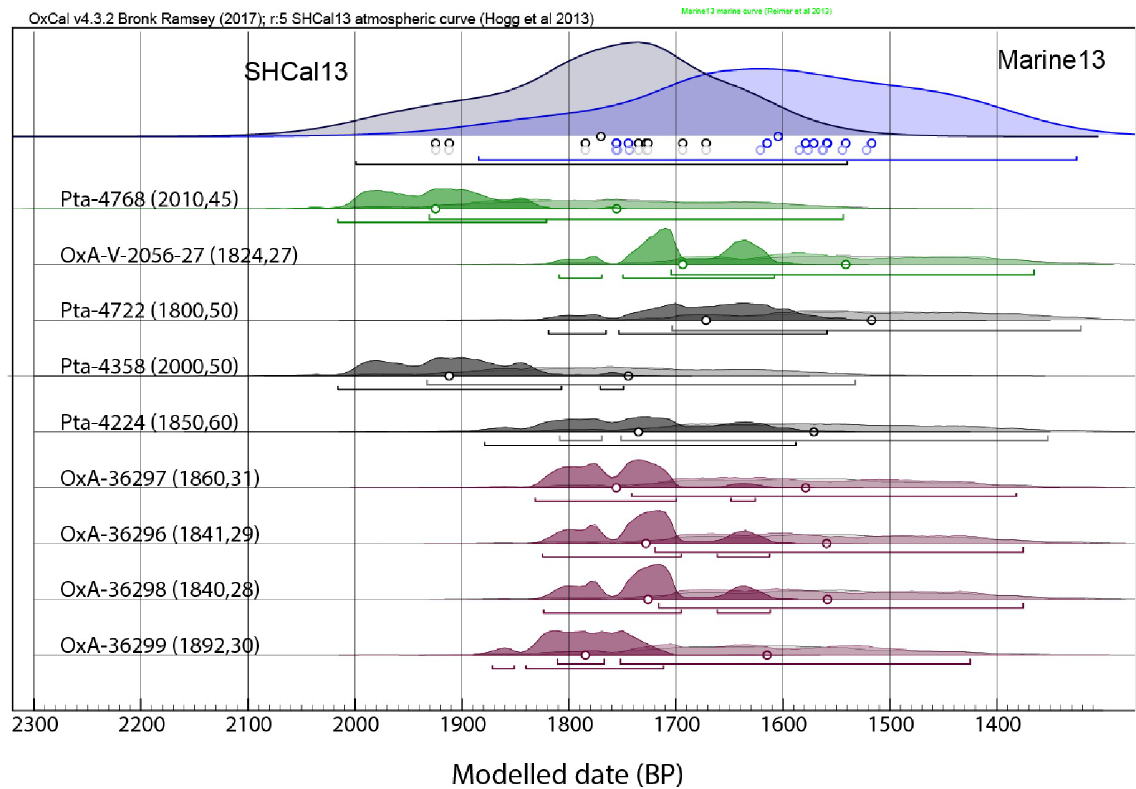
Fig 10. Nine radiocarbon ages for Lagoon Beach human remains. Calibrated using SHCal13 (dark curves) and a Mix_Curve with 15–45% Marine13 curve contribution with local Δ R of 146 ± 85 14 C years [77, 82]. The two dates on individual SAM-AP6041A are in green, and the four dates from the four individuals removed as a single unit in 1997 are in purple. The modelled KDE aggregations of all nine dates are indicated in blue.